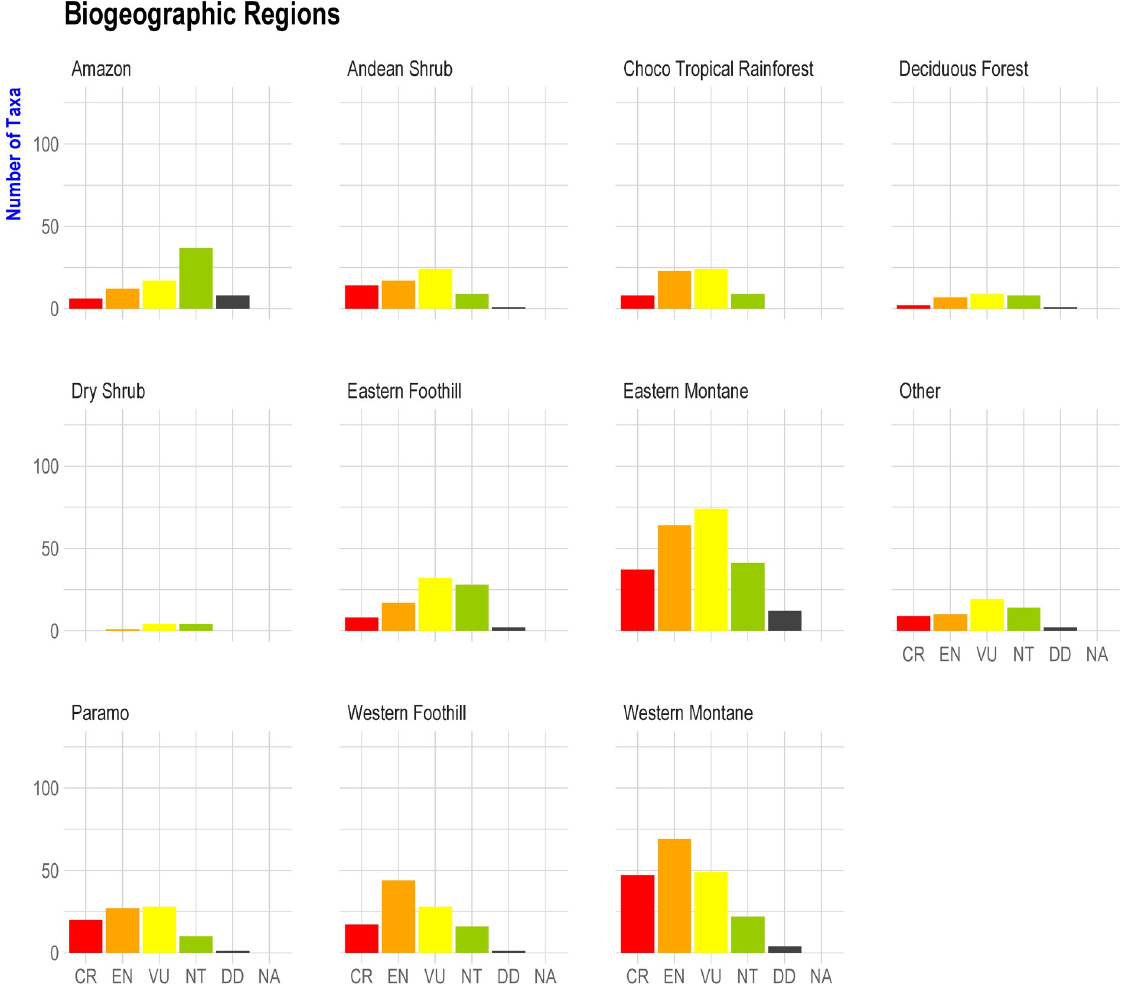
Fig 9. Frequency of locality records of amphibians in each risk category by natural regions in Ecuador. Categories: CR = Critically Endangered, EN = Endangered, VU = Vulnerable, NT = Near Threatened, DD = Data Deficient. Least Concern taxa have been removed from this